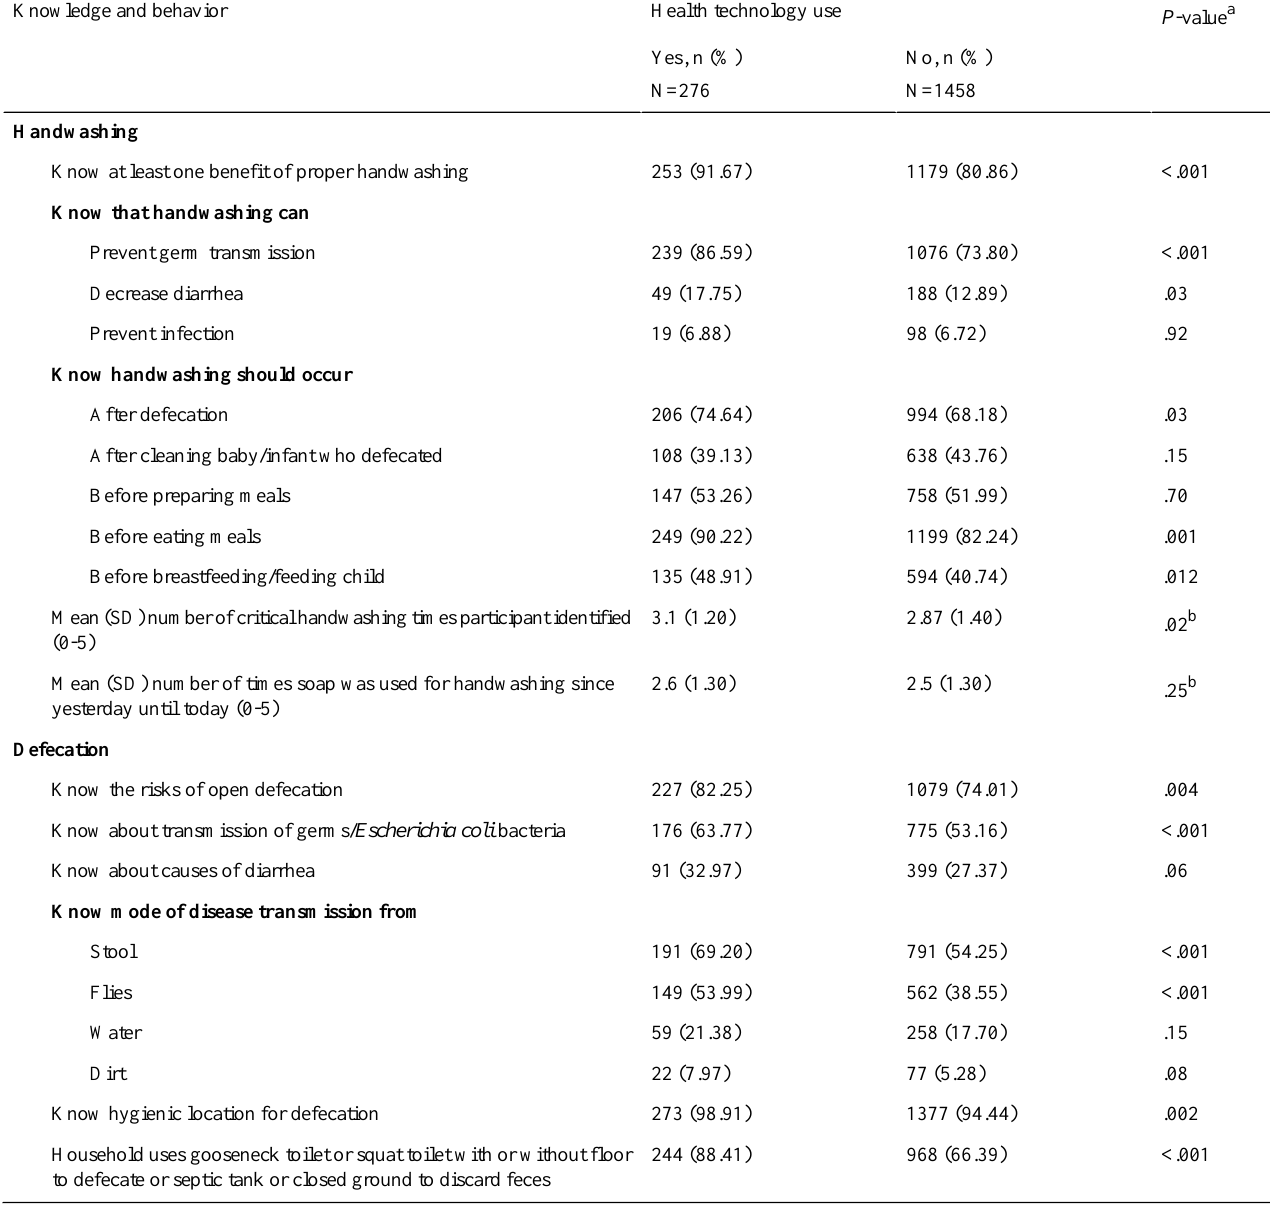
Table 2. Knowledge and behaviors of handwashing and defecation by use of health technology among Indonesian women in Banyuasin, Kubu Raya, and Katingan in 2018.